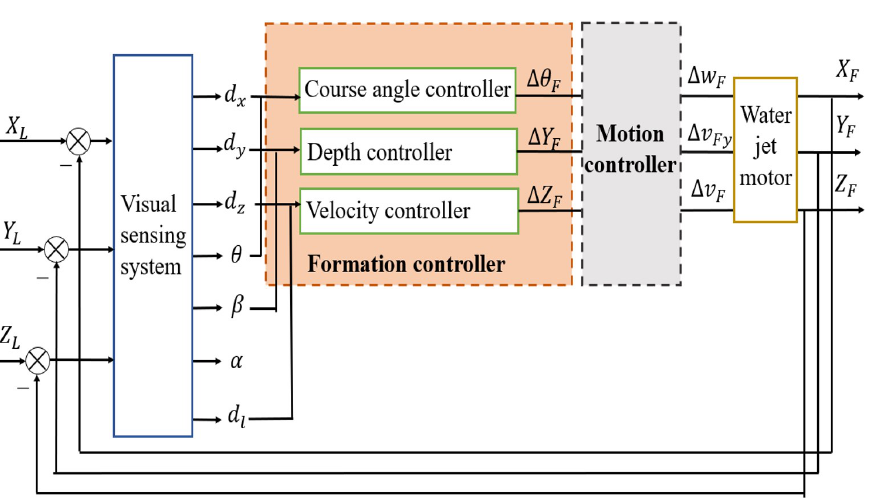
Figure 9. The control diagram of the leader-follower formation system based on vision